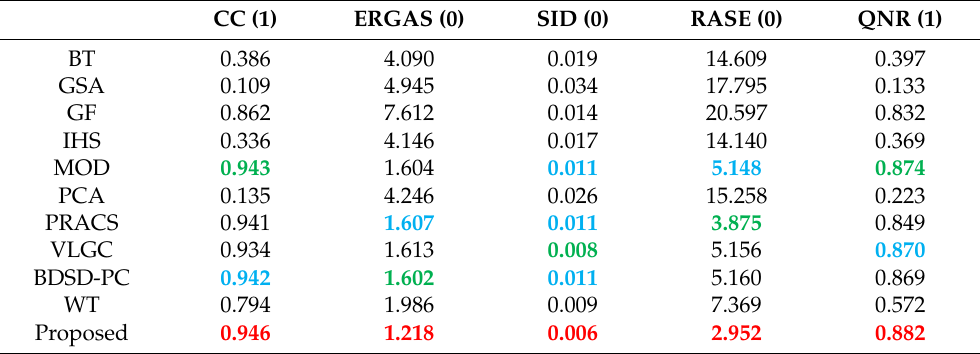
Figure 7. The fusion results of ten different methods on the second image pair: ( a ) BT; ( b ) GSA; ( c ) GF; ( d ) IHS; ( e ) MOD; ( f ) PCA; ( g ) PRACS; ( h ) VLGC; ( i ) BDSD-PC; ( j ) WT; ( k ) the proposed method; ( l ) the reference MS image. Table 4. Objective evaluation of the experimental results on the third image Table 3. Objective evaluation of the experimental results on the second image pair.